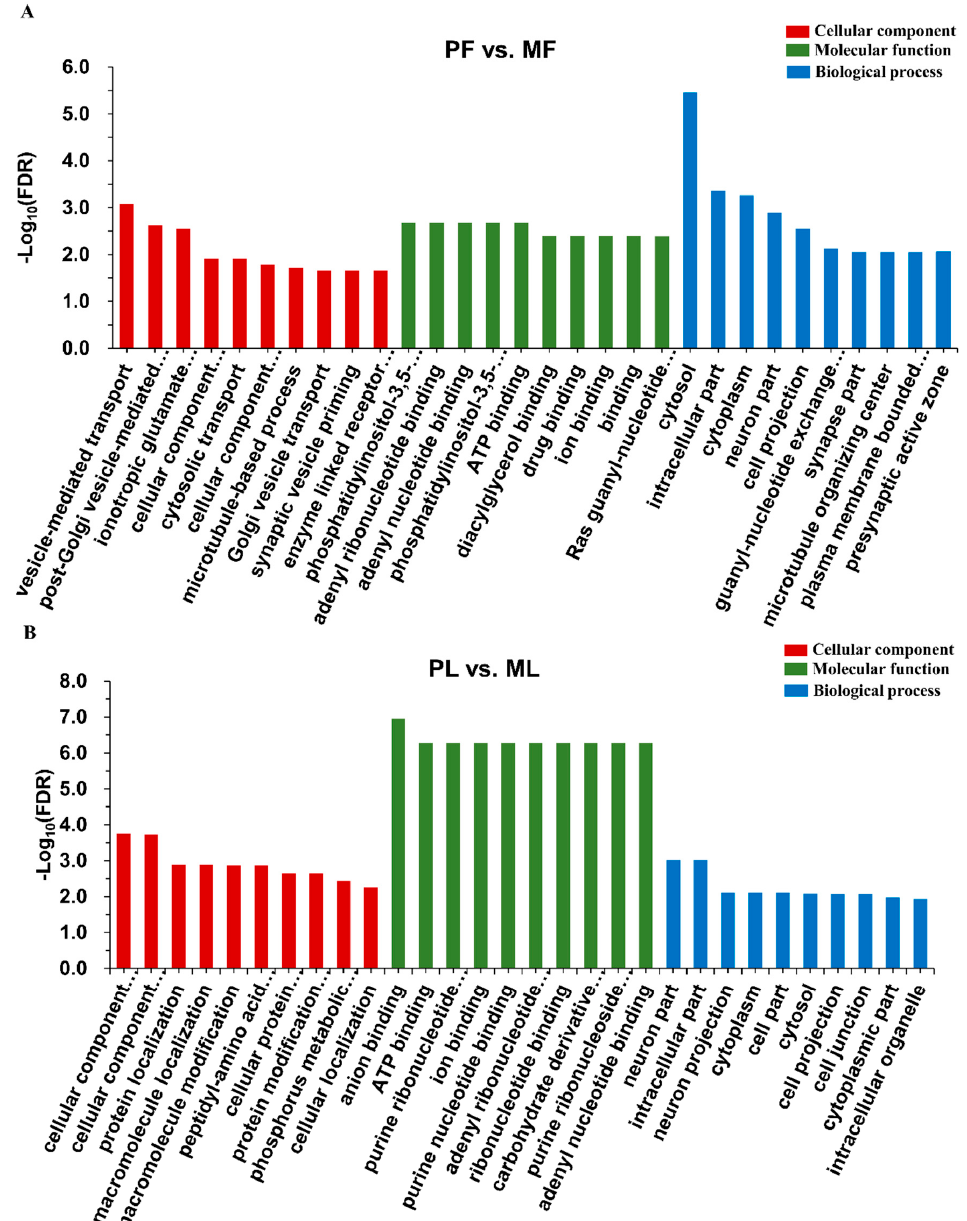
Figure 6. Gene ontology functional enrichment analysis. ( A ) The top ten enriched GO terms in biological process, molecular function, and cellular component, respectively, in polytocous sheep in the follicular phase versus monotocous sheep in the follicular phase (PF vs. MF). ( B ) The top ten GO terms enriched in biological process, molecular function, and cellular component, respectively, in polytocous sheep in the luteal phase versus monotocous sheep in the luteal phase (PL vs. ML). Notes: FDR: False discovery rate.